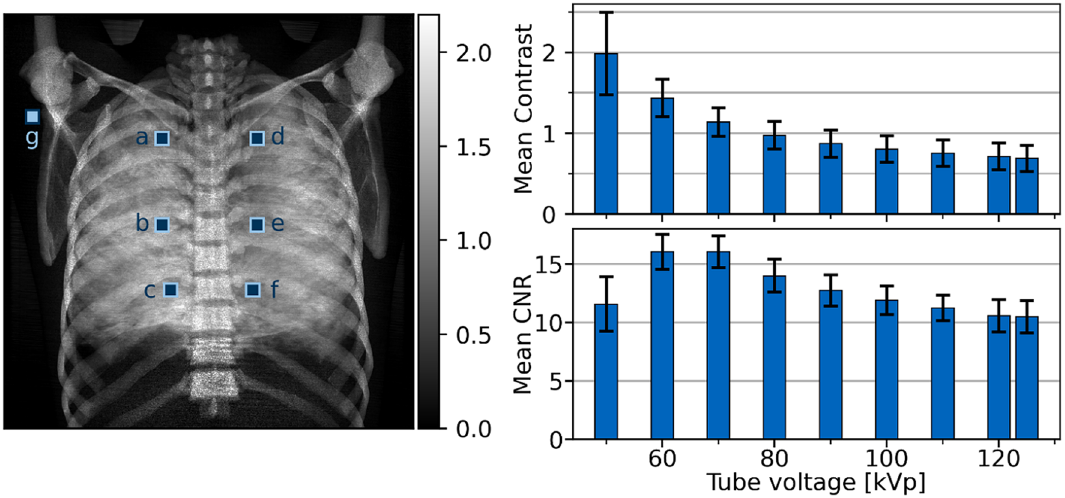
Figure 3. Left: Dark-field image of the Lungman, acquired with a tube voltage of 70 kVp. In the image position of the ROIs in the lung ( a – f ) and the position of the ROIs in the vicinity of the lung ( g ) are highlighted. Right: Mean contrast (top) and mean CNR (bottom) of the dark-field lung signal plotted for all examined tube